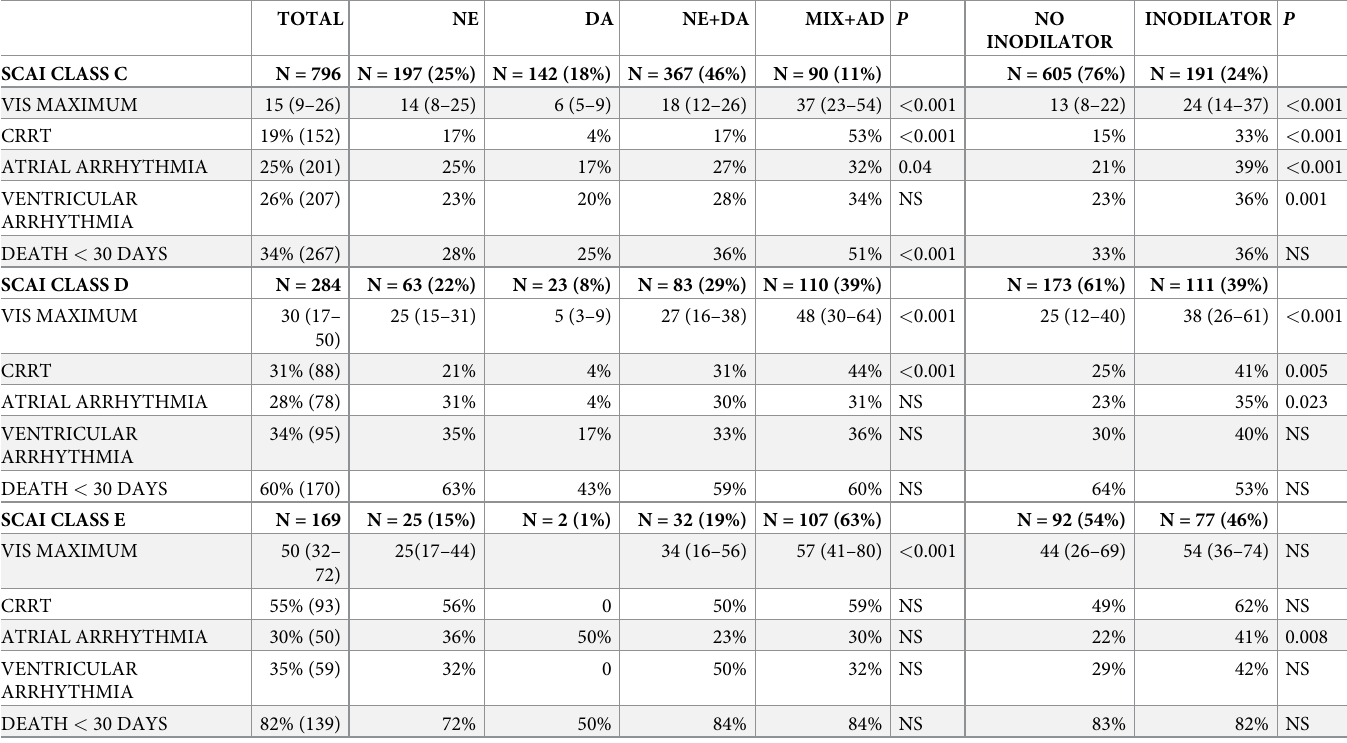
Table 4. Vasoactive treatment and association with arrhythmias, renal replacement therapy and 30-day mortality in each SCAI